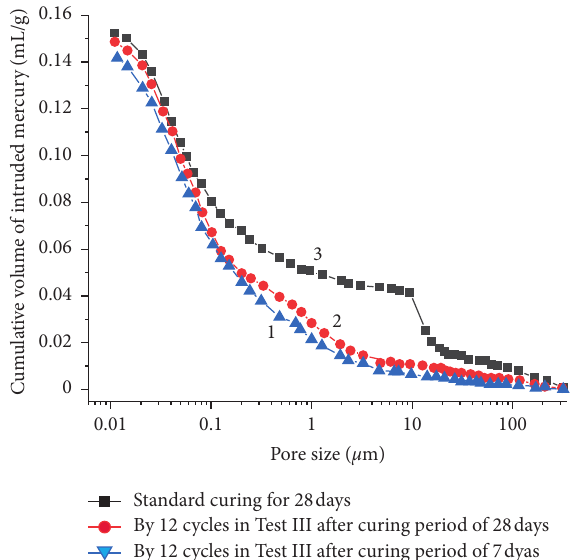
Figure 6: Pore size distribution of specimens stabilized by 10% stabilizer.